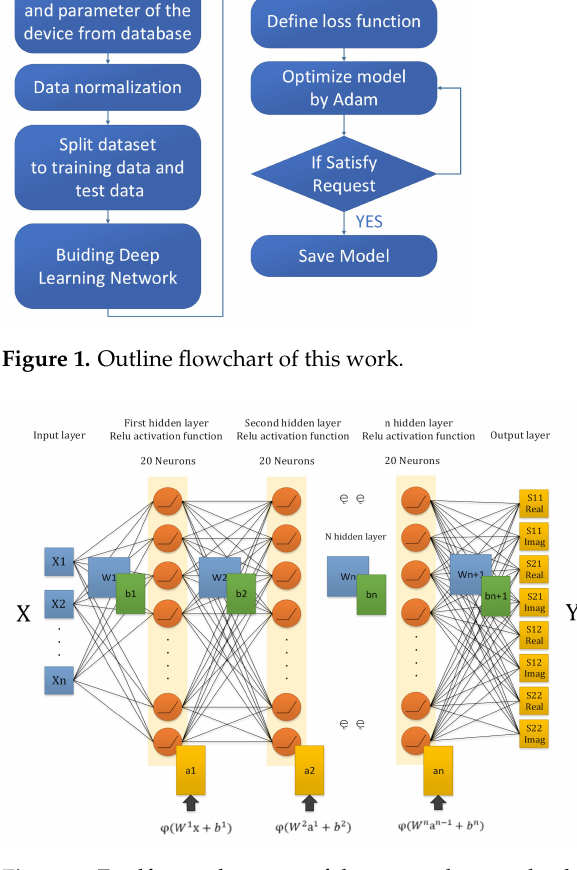
Figure 2. Feedforward process of deep neural network adopts multi-layer fully connected structure. The input data X of the neural network is the geometric parameters and the operating frequency of RF devices, whereas the output data Y are the real part and the imaginary part of the S